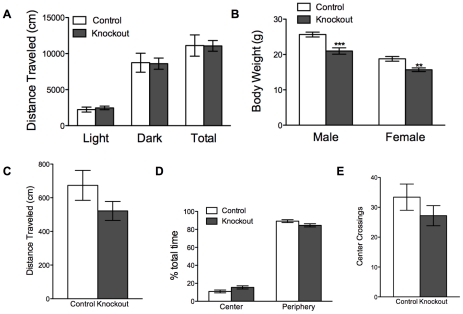
Knockout mice are smaller than normal but have normal spontaneous locomotion, and intact exploratory behavior.
(A) Spontaneous locomotion by control (n = 10) and knockout (n = 11) animals; light cycle, P = 0.85; dark cycle, P = 0.93; total, P = 0.98 by unpaired t tests. (B). Body weight of 8-week-old animals; control (n = 15) and knockout (n = 12) males, P<0.0001; control (n = 11) and knockout (n = 10) females, P = 0.002 by unpaired t tests; **P<0.01; ***P<0.0001. (C) Locomotor activity of control (n = 10) and knockout (n = 5) animals in an open field; P = 0.17 by unpaired t test. (D) Fraction of time spent in the center and periphery of the open field by control (n = 10) and knockout (n = 5) animals; P = 0.08 by unpaired t tests. (E) Number of open-field center crossings by control (n = 10) and knockout (n = 5) animals; P = 0.28 by unpaired t test.